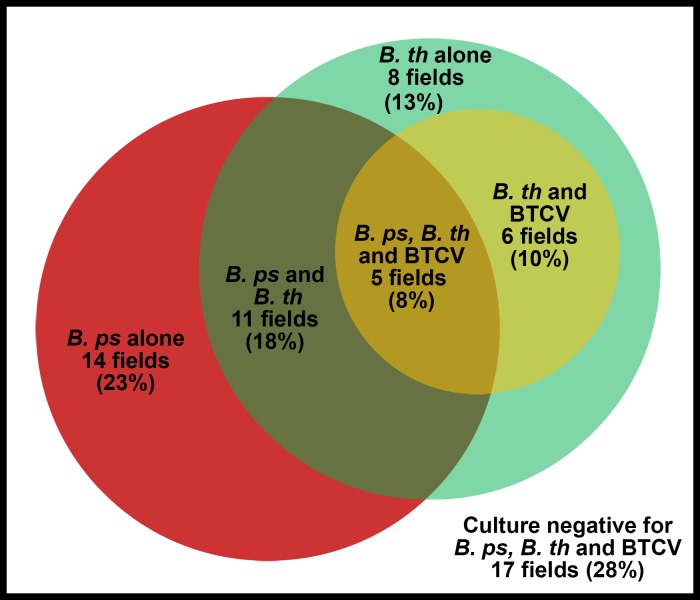
Overlap between presence of B. pseudomallei (B. ps; red), B. thailandensis (B. th; green) and B. thailandensis expressing B. pseudomallei-like capsular polysaccharide (BTCV; yellow) in 61 sampled rice fields.